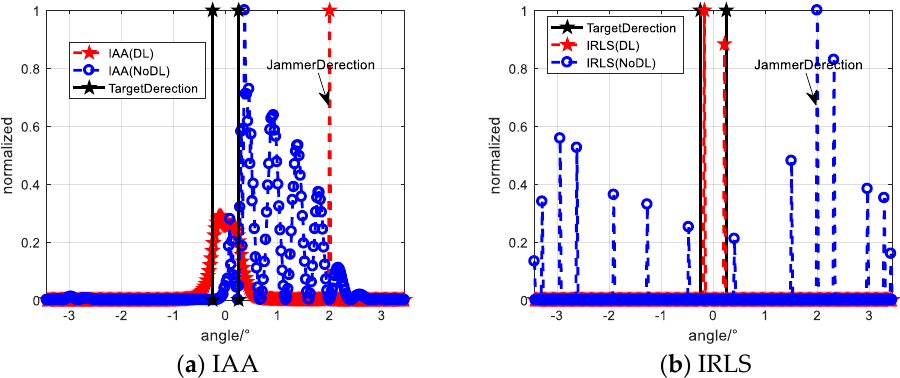
Figure 3. Comparison of algorithm before and after diagonal loading (under near main-lobe interference).